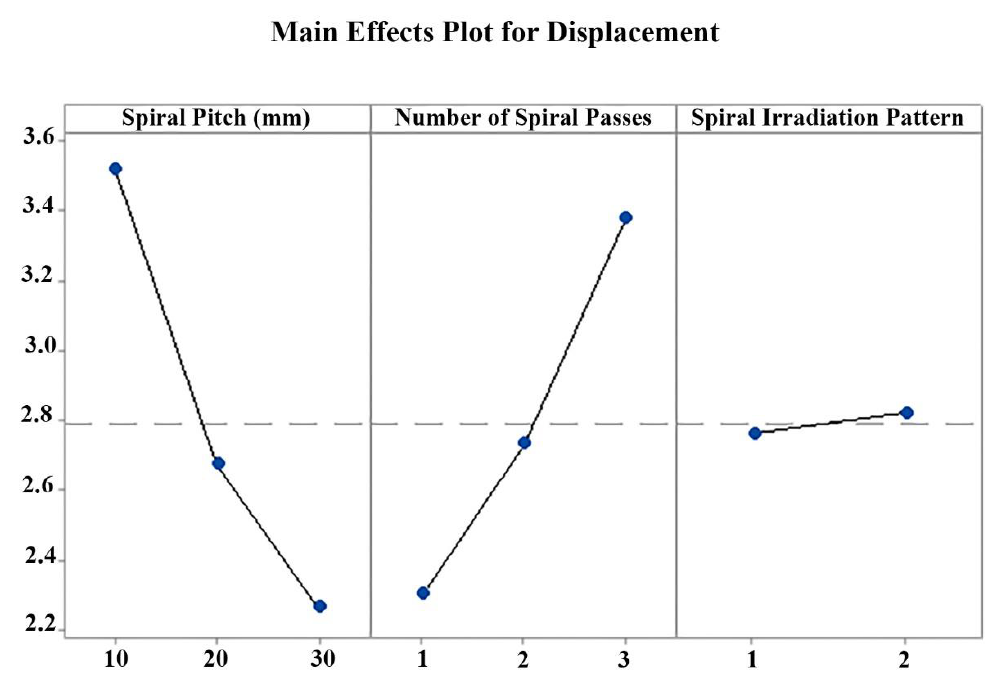
Figure 3. Plots of main effects on the displacement of sample point H.